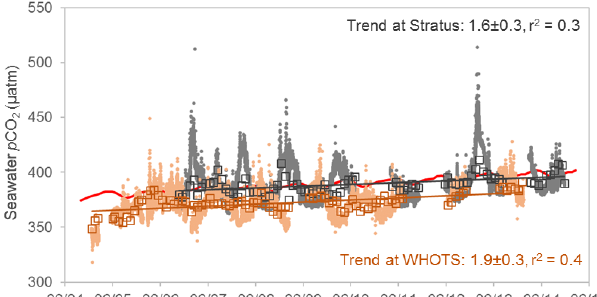
Figure 6. Surface seawater p CO 2 (µatm) 3-hourly observations (dots), deseasoned monthly anomalies (squares), and trends (lines) for the Stratus (dark gray) and WHOTS (brown) time series. The time series in red is monthly averaged atmospheric x CO 2 (µmolmol − 1 ) from Mauna Loa, Hawaii (NOAA ESRL Global Monitoring Division, 2016). Dates are